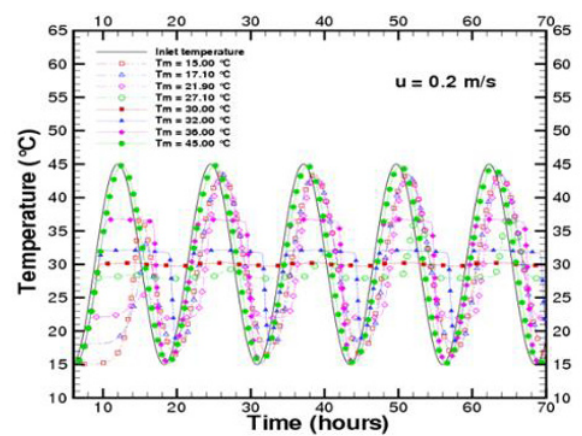
Fig. 2. Time evolution of the working fluid inlet and outlet temperatures for different PCM melting temperatures (sinusoidal inlet temperature)